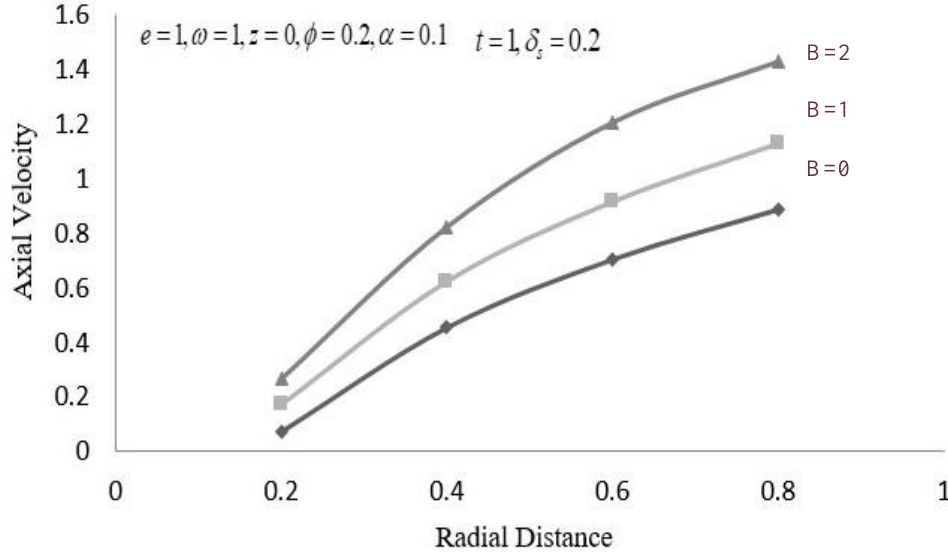
Figure 2. Axial velocity with radial distance for different value of body